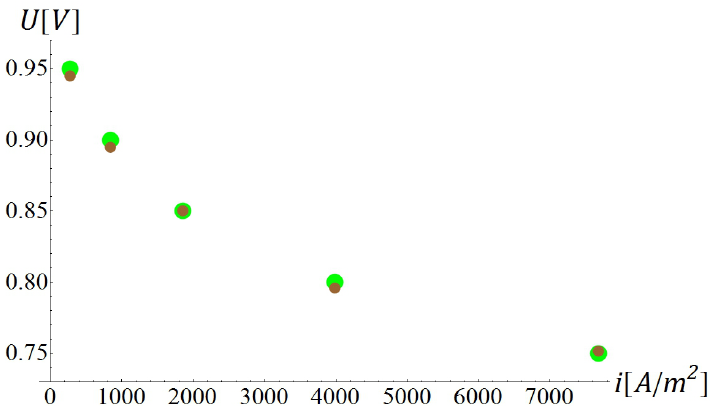
Figure 8. Polarisation curve. Green are CFD results of current density obtained at voltages: 0.95 V, 0.9 V, 0.85 V, 0.8 V and 0.75 V. Brown are HAN current densities that match those of